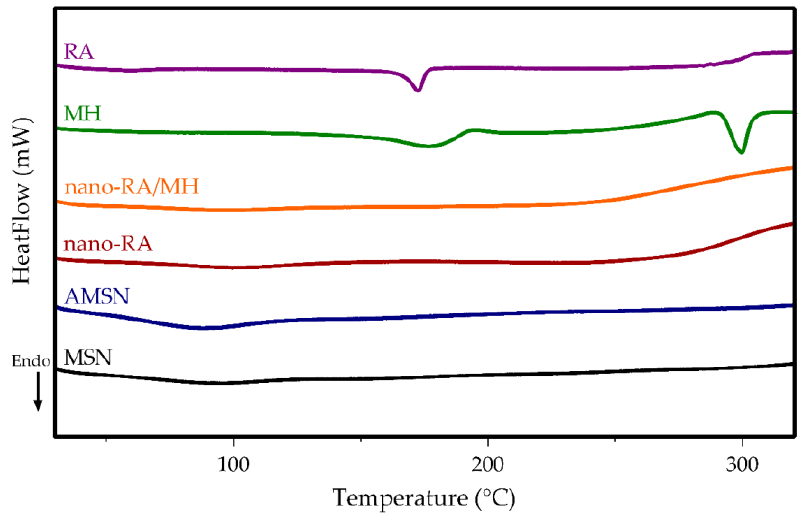
Figure 4. DSC thermogram of MSN (black line), AMSN (blue line), nano-RA (red line), nano-RA/MH (orange line), MH (green line), and RA (purple line).